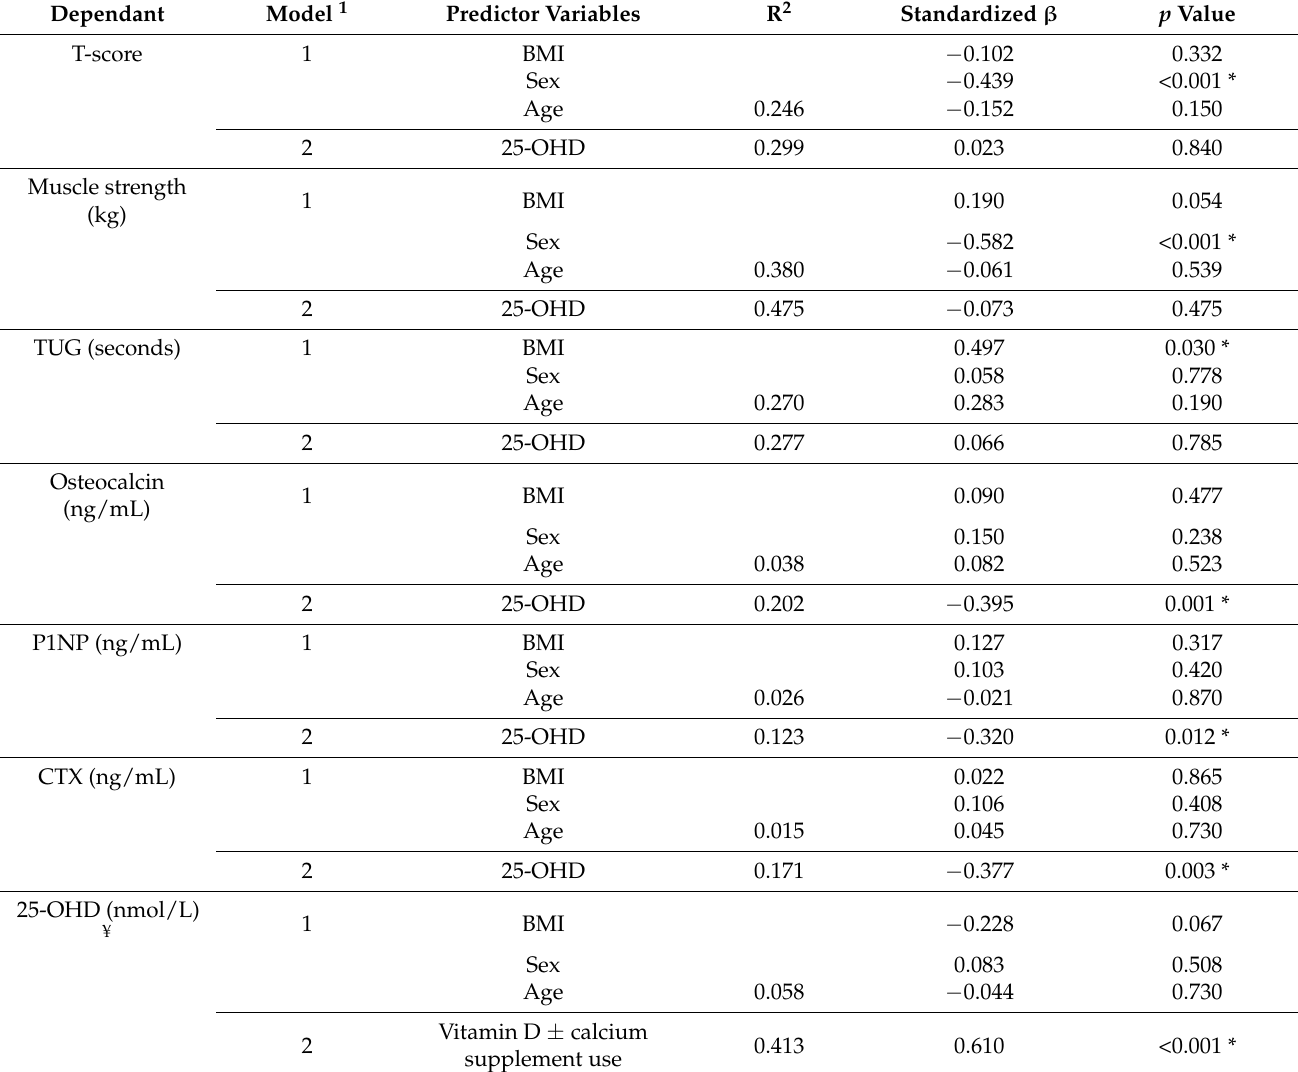
Table 3. Multiple regression showing associations between 25-OHD concentration and physical and biochemical parameters in care home